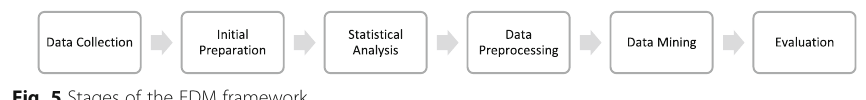
Fig. 5 Stages of the EDM